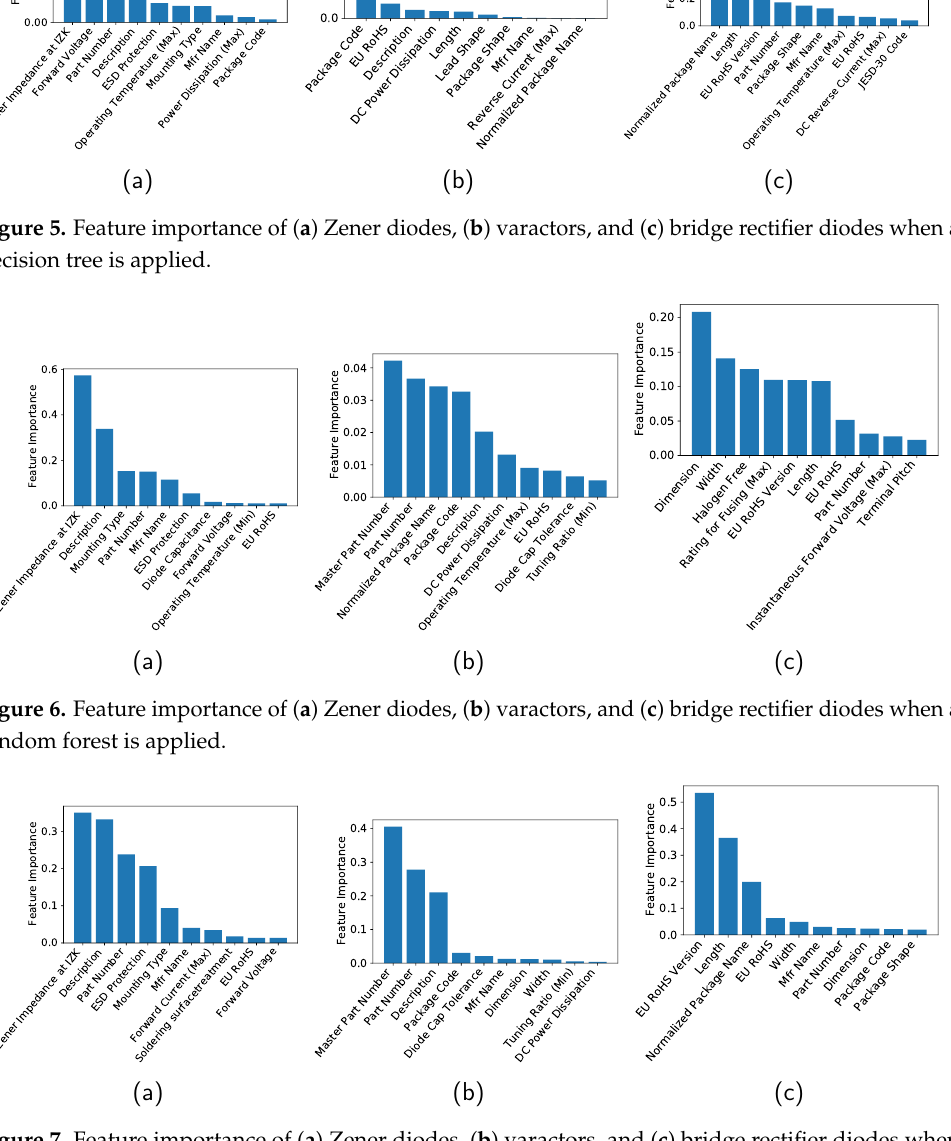
Figure 7. Feature importance of ( a ) Zener diodes, ( b ) varactors, and ( c ) bridge rectifier diodes when gradient boosting is